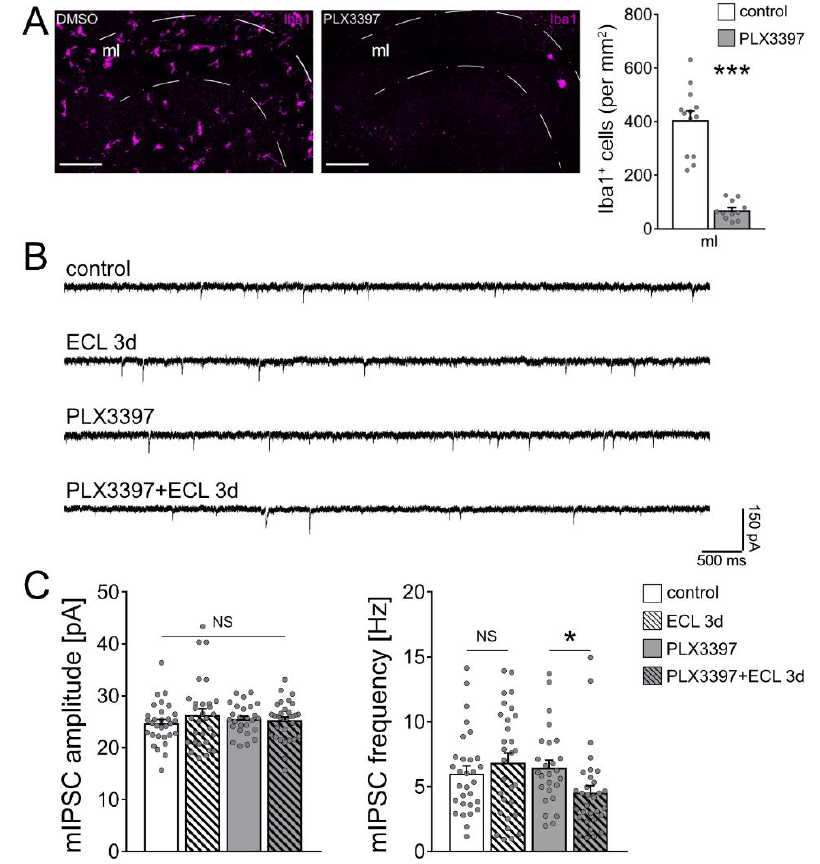
Figure 5. Microglia maintain inhibition onto partially denervated dentate granule cells . ( A ) Representative images of vehicle-only (i.e., dimethyl sulfoxide, DMSO) treated controls and PLX3397 (50 nM) treated tissue cultures, stained for the microglial marker Iba1, and group data of numbers of Iba1 + cells in the molecular layer (ml) of the dentate gyrus (control, n = 13 cultures; PLX3397, n = 11 cultures; Mann – Whitney test; *** p < 0.001). Scale bar 100 µm. ( B ) Sample traces of GABA receptor-mediated miniature inhibitory postsynaptic currents (mIPSCs) recorded from dentate granule cells in the respective groups. ( C ) Group data of GABA receptor-mediated mIPSC recordings (untreated control, n = 30 cells from 8 cultures; untreated ECL 3d, n = 30 cells from 6 cultures; PLX3397, n = 26 cells from 6 cultures; PLX3397 + ECL 3d, n = 32 cells from 7 cultures; Kruskal – Wallis test followed by Dunn’s post hoc test; * p < 0.05; NS, non-significant difference).